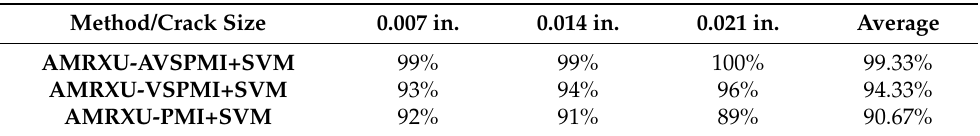
Table 10. The average accuracy in roller crack size detection using the proposed AMRXU-